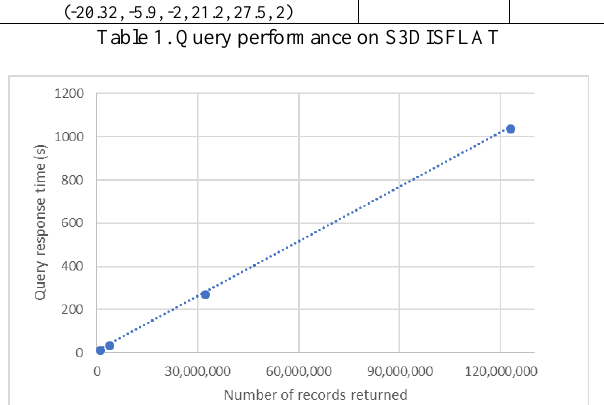
Figure 5. LoD selection (Query 2) at different levels. The tendency shows a linear scalability and Time = 8 x 10 -6 n + 11.73, where n is the output size.